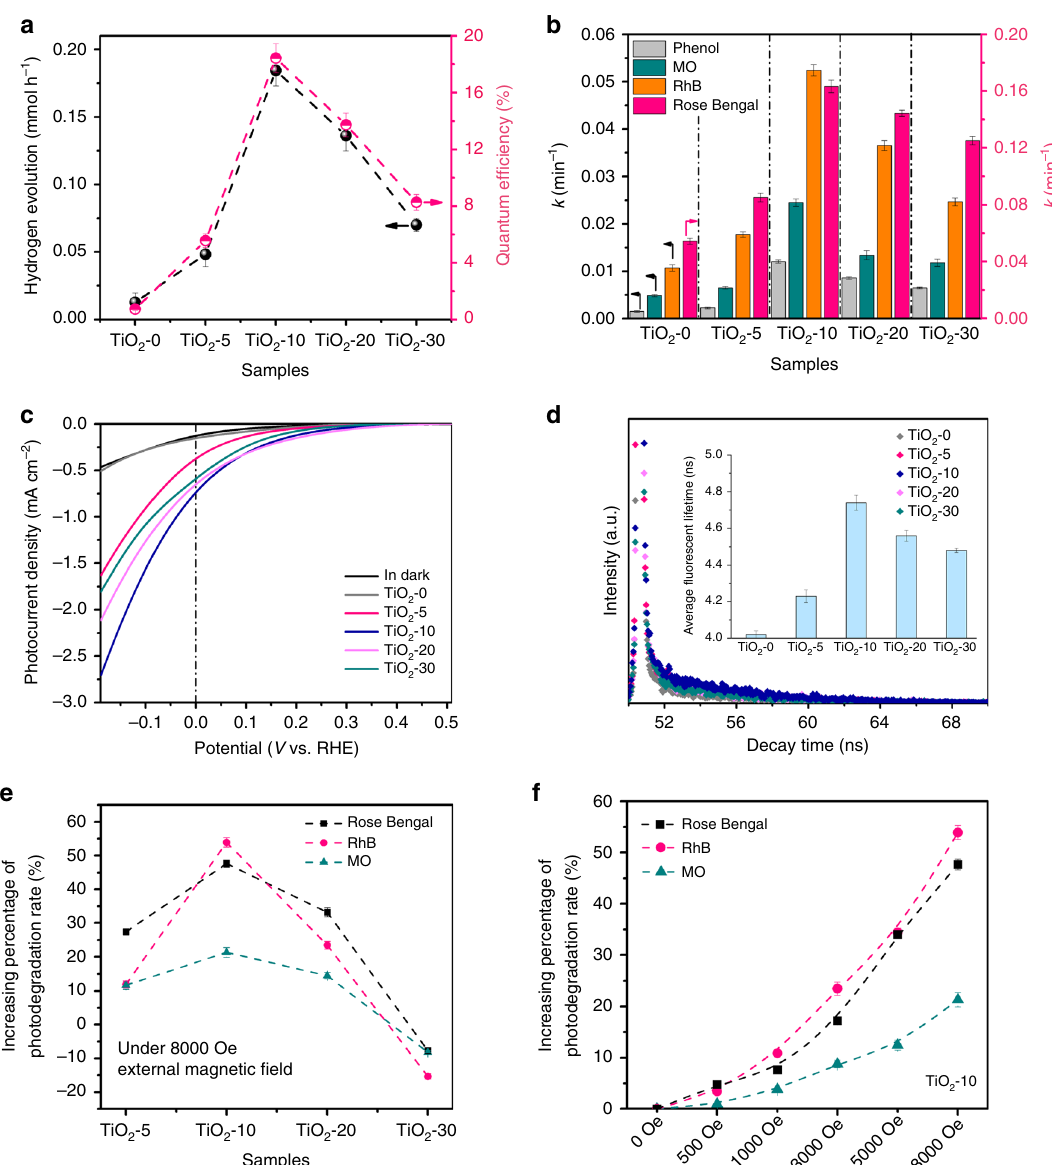
Fig. 4 Photocatalytic performance of metal-defected TiO 2 . a Photocatalytic H 2 evolution and quantum ef fi ciency (QE); b The degradation rates of four organic pollutants (Phenol, MO, RhB, Rose Bengal); c Liner sweep voltammetry (LSV) curves of TiO 2 - m (photoelectrodes) under light irradiation and in dark; d Time-resolved transient PL decay; e Increasing percentage of photodegradation rates of Ti-defected samples under 8000 Oe external magnetic fi eld; f Increasing percentage of photodegradation rates of TiO fi eld from 0 to 8000 2 -10 under different strength of magnetic